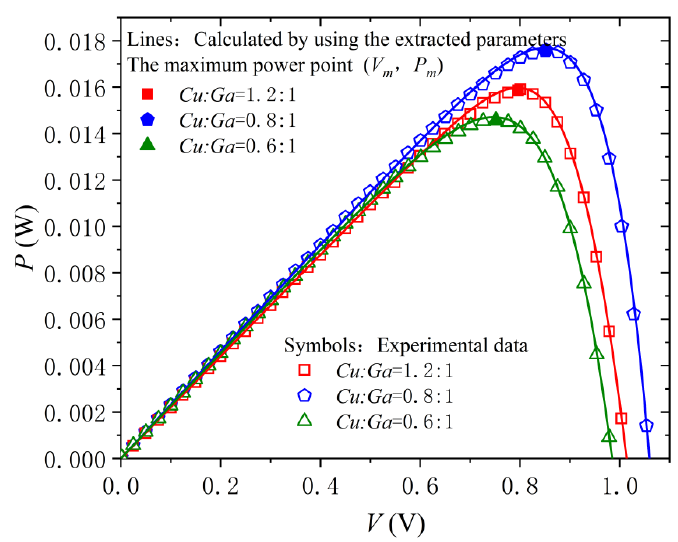
Figure 5. P-V characteristics measured and calculated, respectively.